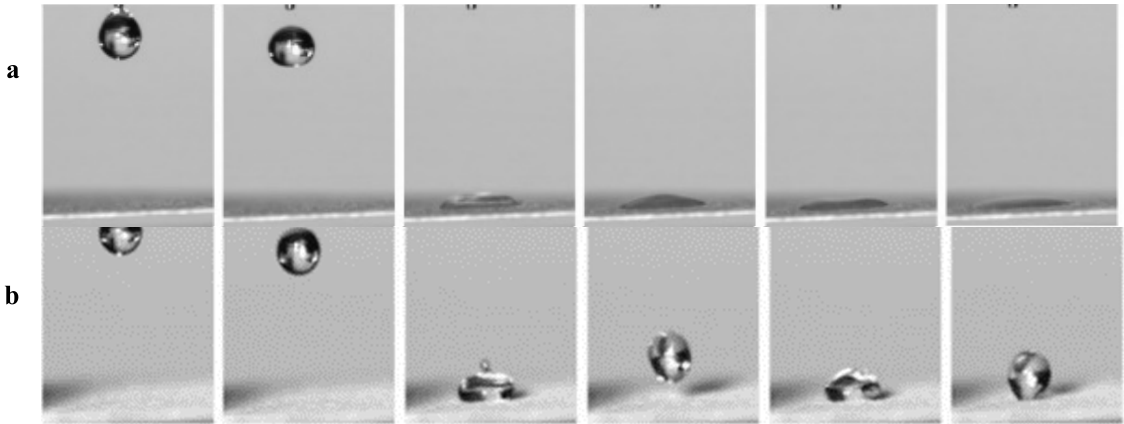
Figure 2. Time-lapse photographs of water droplets bouncing on the pristine qualitative filter paper ( a ) and the modified filter paper fabricated by 0.3% both nanoparticles ( b ).